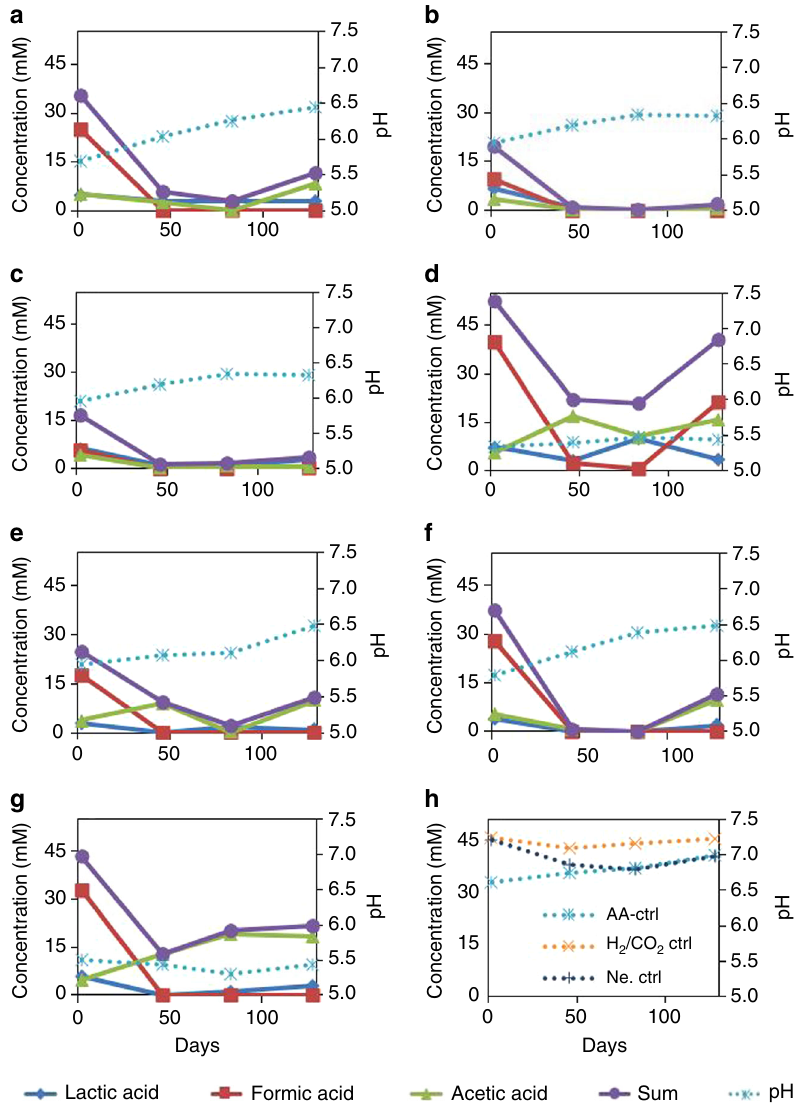
Fig. 6 Intermediate organic acids and pHs at sampling intervals. The sampling intervals are day 2, 46, 83 and 128. Each data point represents an average value of three replicates. a Galactose; b mannose; c glucose; d cellobiose; e xylose; f arabinose; g mix; h controls (pH